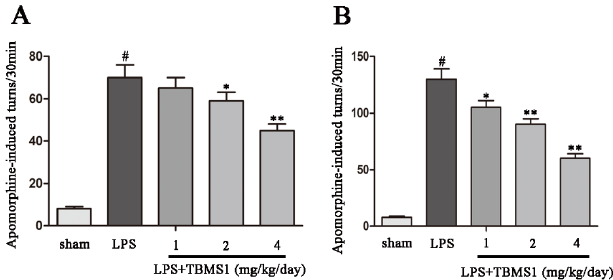
Figure 1. Tubeimoside I (TBMS1) improves the behavioral dysfunction of lipopolysaccharide (LPS)-induced Parkinson’s disease (PD) rat model. The rats were pretreated with TBMS1 (1, 2, 4 mg/kg/day) for three days before LPS injection and, subsequently, for 21 days after LPS injection. The number of turns induced by amphetamine were counted at two ( A ) and four weeks ( B ). # p < 0.01 versus the sham-operated group. * p < 0.05 and ** p < 0.01 versus the TBMS1-untreated LPS-injected group, and statistical significance was determined by